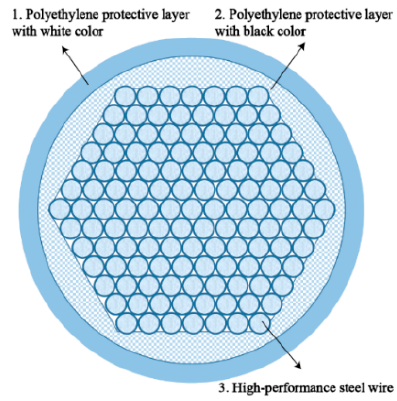
Figure 2. Experimental set-up.